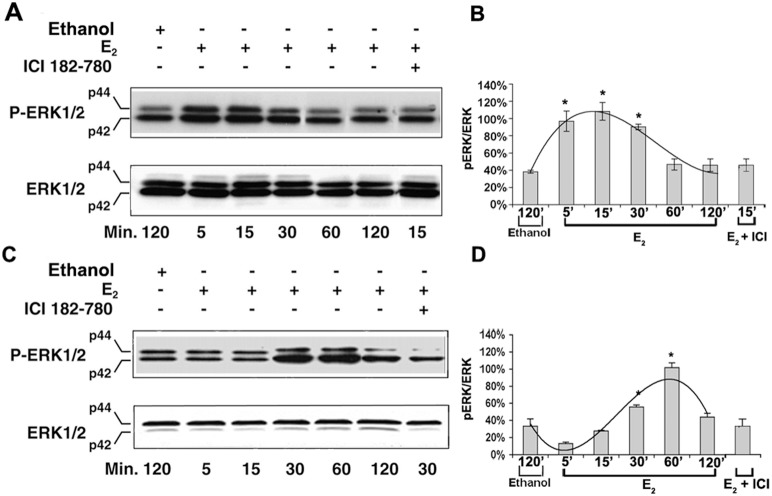
In A1 cells, E2 induce ERK1/2 phosphorylation according to the proliferative/differentiation status.Western blot detection of p-ERK1/2 and ERK1/2 proteins in proliferating/undifferentiated (A) and non-prolifearting/differentiated A1 cells (C) treated at indicated time with 10 nM of E2 and 10 mM of ICI 182–780. Two specific bands were observed respectively at 44 and 42 kDa. Each blot is representative of three separate experiments. The diagrams show the relative quantitation of p-ERK1/2 and ERK1/2 in proliferating (B) and non-proliferating (D) A1 cells. Data are expressed as ratios of p-ERK1-2/ERK1-2. In diagrams are also showed the different trend lines of the kinetic of p-ERK following E2 stimulation. Asterisks represent p<0.01 when compared to control cultures treated with vehicle (ANOVA, Scheffè F-test).